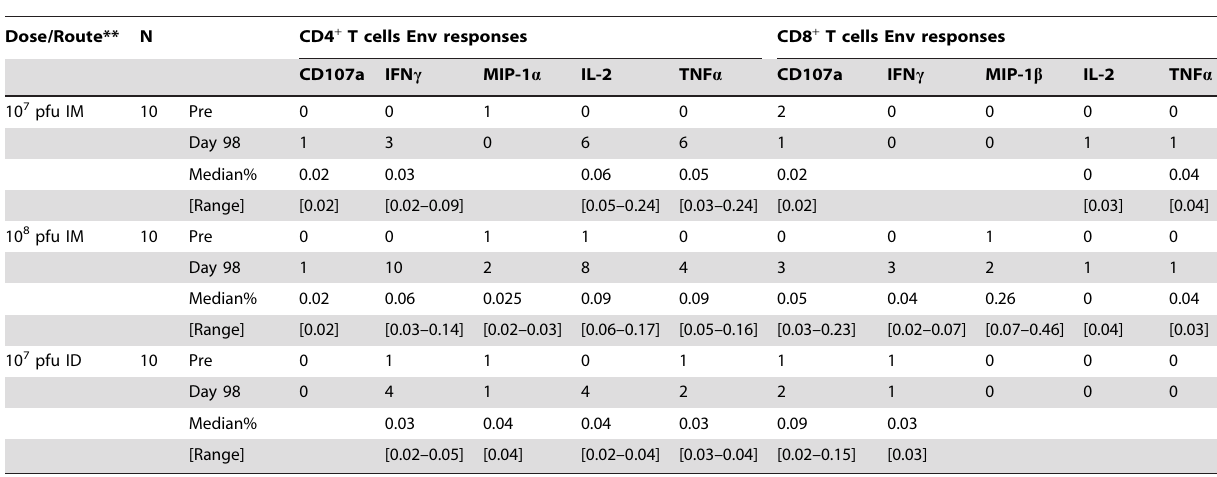
Table 5. Multi-Functional Flow Cytometry Results (Env peptide pool responses)*.